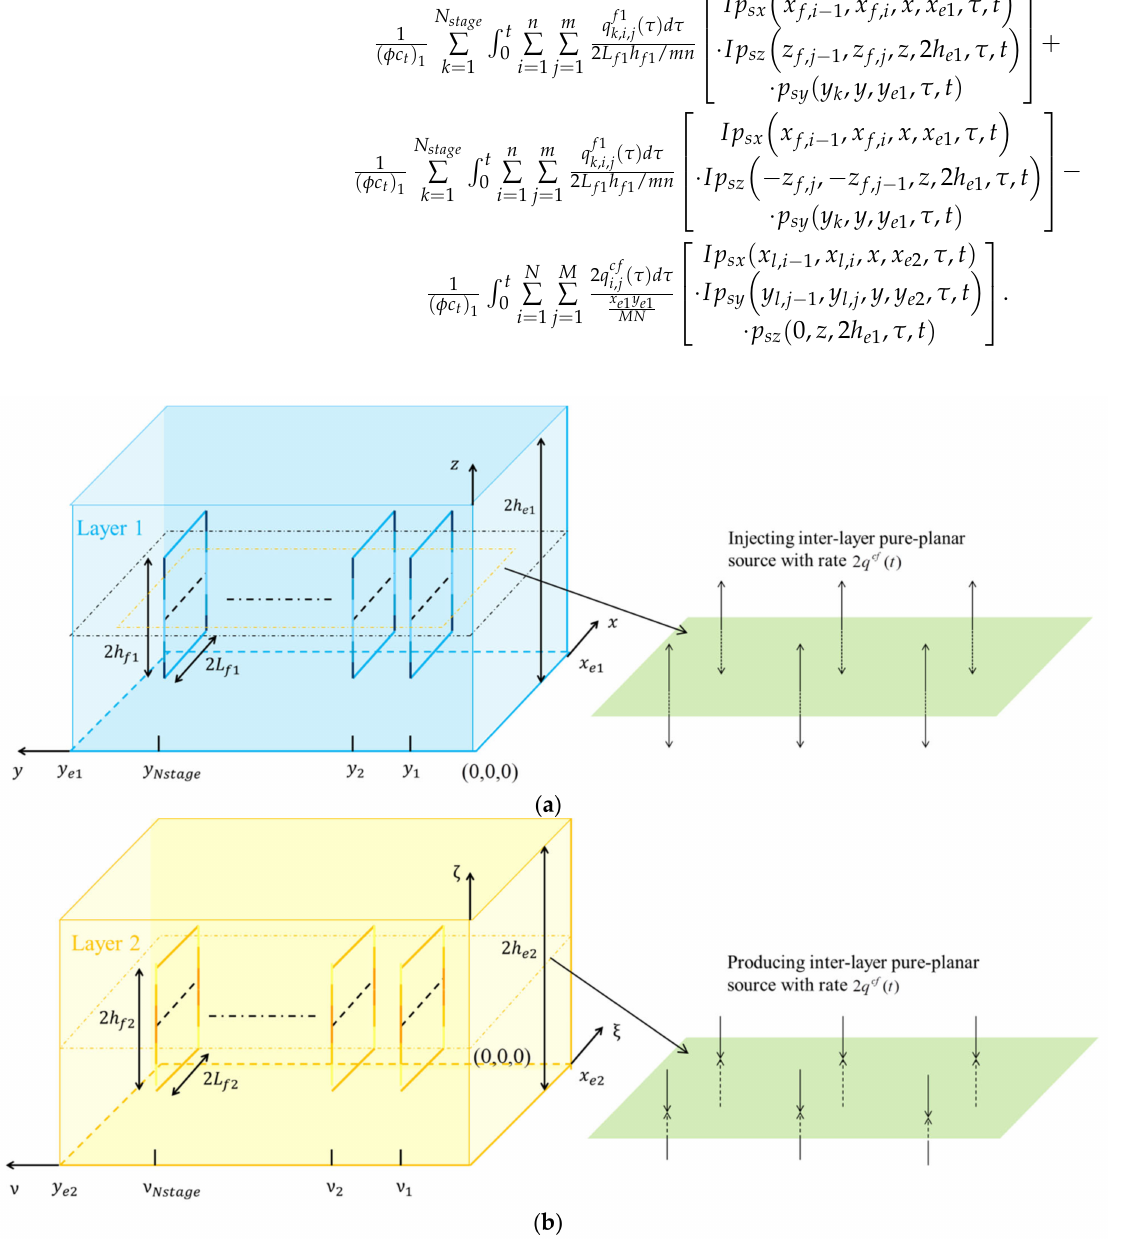
Figure 4. ( a ) Layer 1 discretized from reservoir, ( b ) Layer 2 discretized from reservoir, by applying the pure-plane concept to integrate